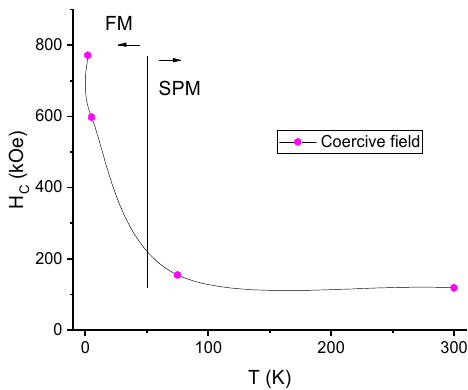
Figure 5. Temperature dependence of the coercive field in Mn 53 Al 45 C 2 sample. The two magnetic regimes (FM and SPM) are evidenced in the figure.